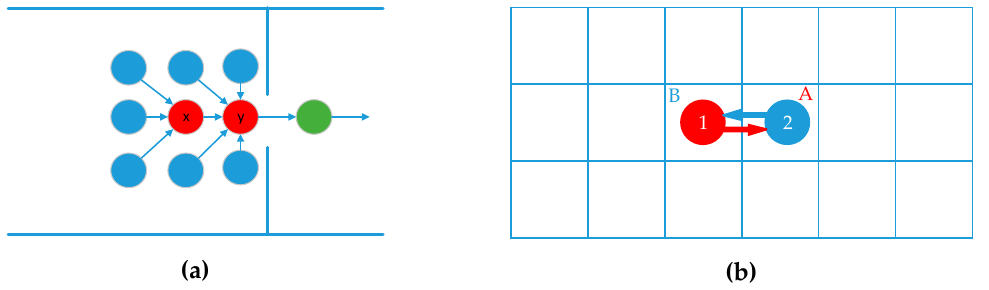
Figure 5. The nature of congestion and conflict: ( a ) congestion in nodes x and y; ( b ) conflict situation. Both agents tend to move toward the space occupied by the other at the same time.